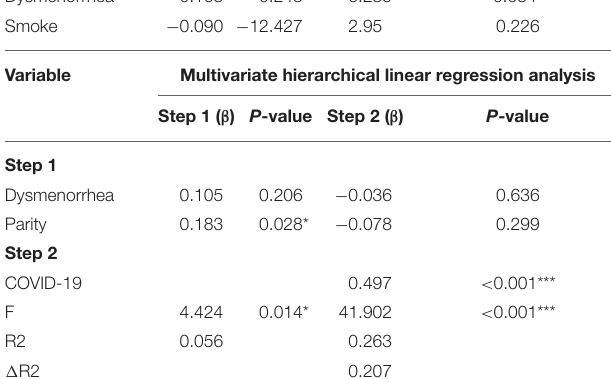
Univariate and multivariate hierarchical linear regression models were used to assess the relationship between COVID-19 clinical characteristics and T; Only the variables showing statistical significance in univariate analysis were included in the multivariate hierarchical linear analysis. # β = standardized regression coefficient. ※ Menstrual status including amenorrhea ≥ 3 months, irregular menstrual cycle, and regular menstrual cycle, as ordered rank variable. *** P < 0.001.